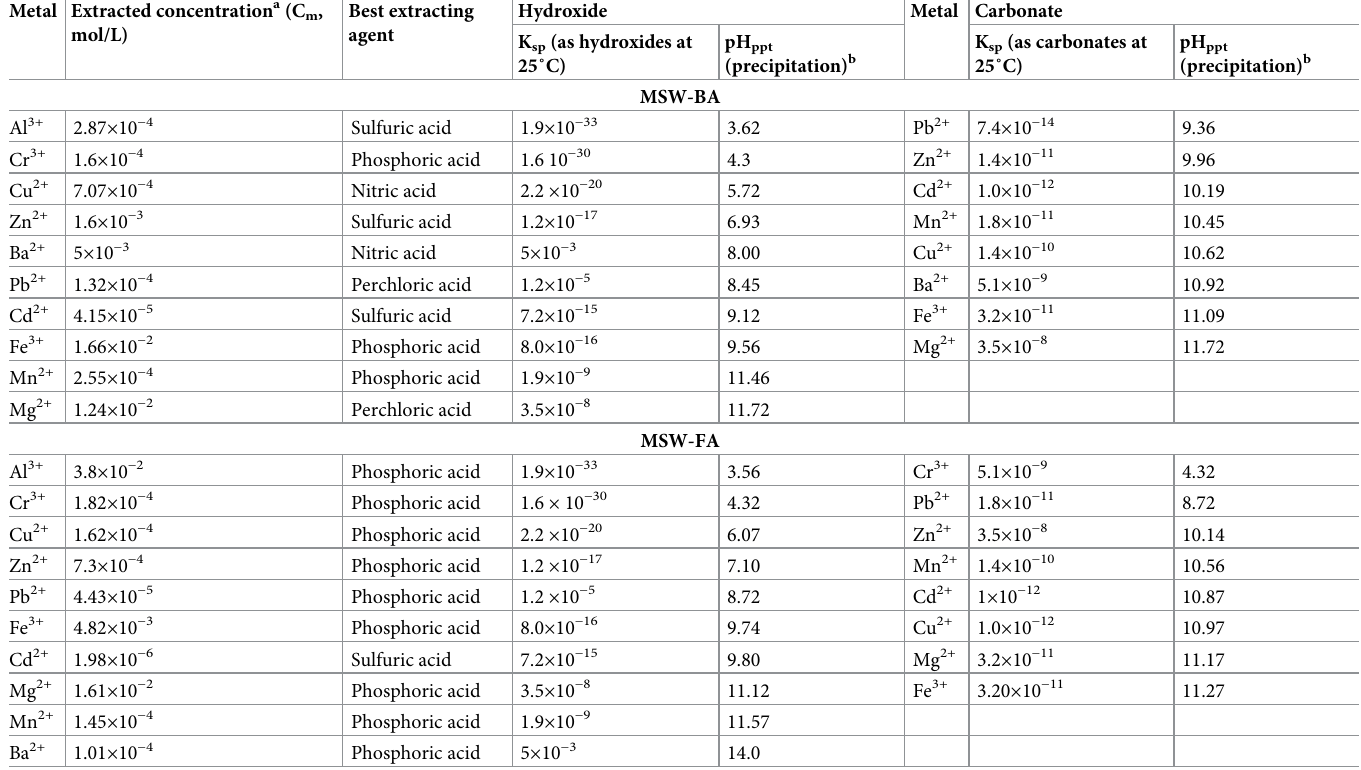
Table 4. K sp values and pH of precipitation for the extracted metals for the MSW-BA and MSW-FA (the K sp values were adapted from solubility product contstant [63]). Metal Extracted concentration a (C m , mol/L)